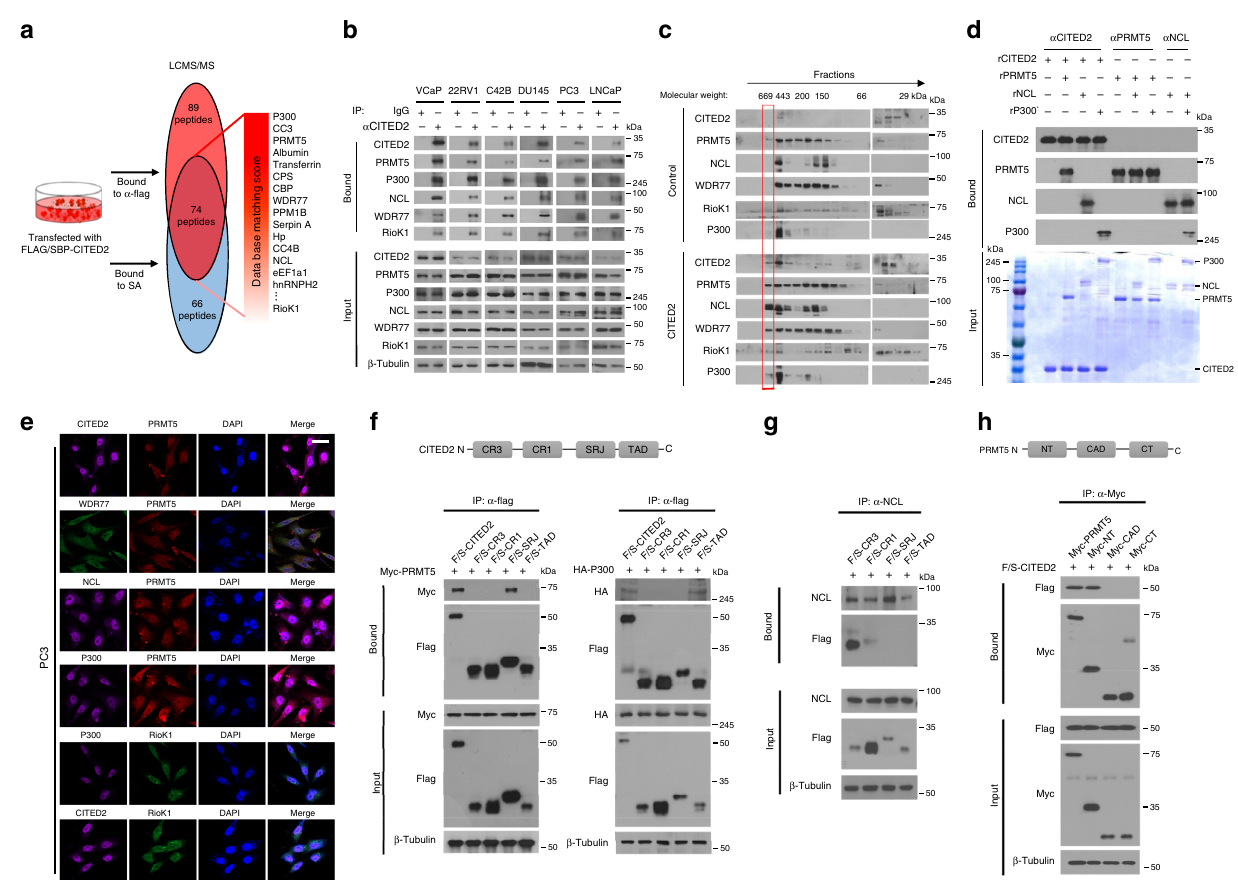
Fig. 3 CITED2 forms a multimeric complex with nucleolin, p300, and PRMT5 subunits. a HEK293T cells were transfected with the Flag/SBP-CITED2 plasmid. CITED2-interacting proteins were precipitated using anti-Flag tag antibody or streptavidin, and identi fi ed by LC-MS/MS analyses. The proteins identi fi ed commonly in two precipitates are listed. b Prostate cancer cell lysates were immunoprecipitated with anti-CITED2 antibody or IgG, and the precipitates were immunoblotted with the indicated antibodies. c HEK293T cells were transfected with pcDNA or CITED2, and the cell lysates were subjected to FPLC. The FPLC elutes were immunoblotted with the indicated antibodies. The red box indicates a bigger-sized complex (600 to 700 kDa) that is formed by CITED2 overexpression. d In vitro binding analysis. Recombinant protein CITED2, PRMT5, NCL, and P300 were put together in a test tube. Proteins in tube were immunoprecipitated with indicated antibodies, and the precipitates were immunoblotted. Input levels were veri fi ed by electrophoresis and Coomassie staining. e Representative immuno fl uorescence images. PC3 cells were grown on coverslips, fi xed with methanol, and stained with the indicated antibodies. All samples were stained with DAPI to visualize nuclei. The scale bar represents 20 μ m. f The Flag/SBP-CITED2 constructs are shown in the top panel. HEK293T cells were cotransfected with one of the CITED2 constructs and Myc-PRMT5, HA-P300, and Flag/SBP- peptides were immunoprecipitated with anti-Flag and Myc-PRMT5 and HA-P300 were detected by western blotting. g HEK293T cells were transfected with the CITED2 constructs, and cell lysates were immunoprecipitated with anti-NCL and Flag/SBP-CITED2 peptides were detected by western blotting. h The Myc-PRMT5 constructs are shown in the top panel. HEK293T cells were cotransfected with one of the PRMT5 construct and Flag/SBP-CITED2, and Myc-peptides were immunoprecipitated with anti-Myc and Flag/SBP-CITED2 were detected by western blotting. All experiments were carried out at